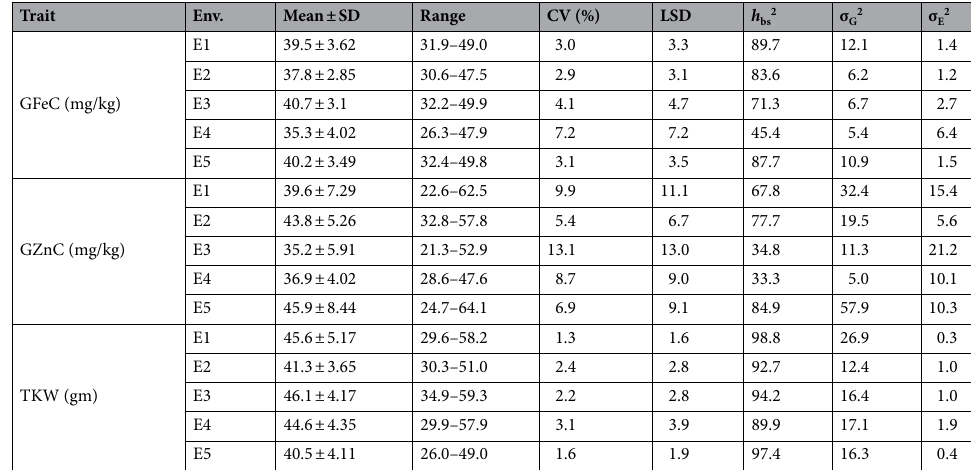
Table 1. Descriptive statistics, variance and heritability estimates of grain quality traits in GWAS panel evaluated at five environments during 2020–2021. GFeC: grain iron concentration; GZnC: grian zinc concentration; TKW: thousand kernel weight; E1-Dharwad; E2-IARI,New Delhi; E3-IARI, Jharkhand; E4-Karnal; E5-Ludhiana; Env.: Environment; SD: standard deviation; CV: coefficient of variation; h 2 bs: broad sense heritability; σ 2 G : genotypic variance; σ 2 E : environmental